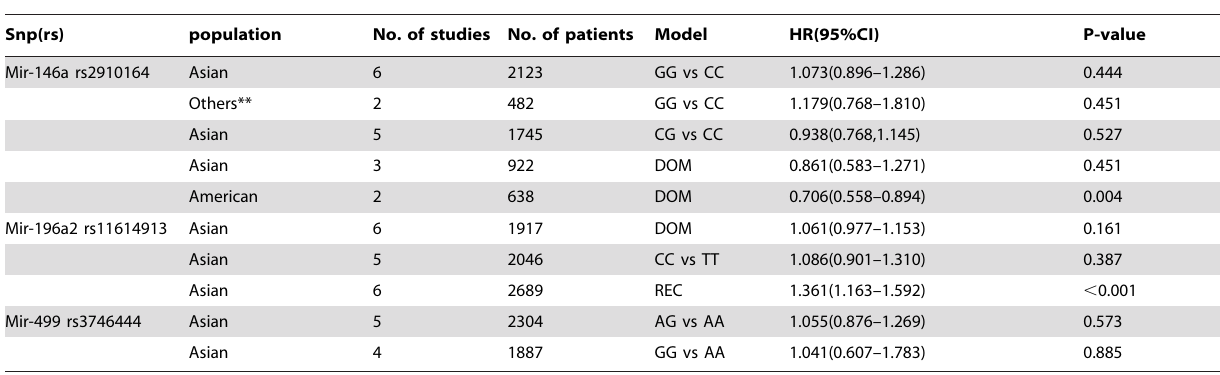
Table 2. Stratified analysis by group for different population OS.